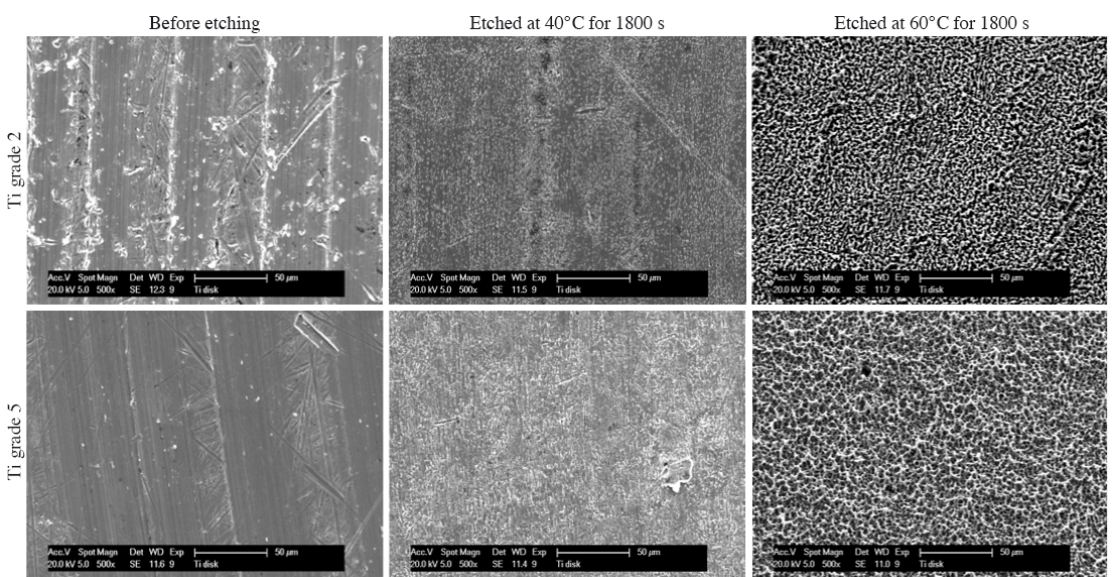
Figure 3. SEM images of grade 2 and grade 5 titanium discs before etching and after etching in HCl at 40°C and 60°C for 1800 seconds.